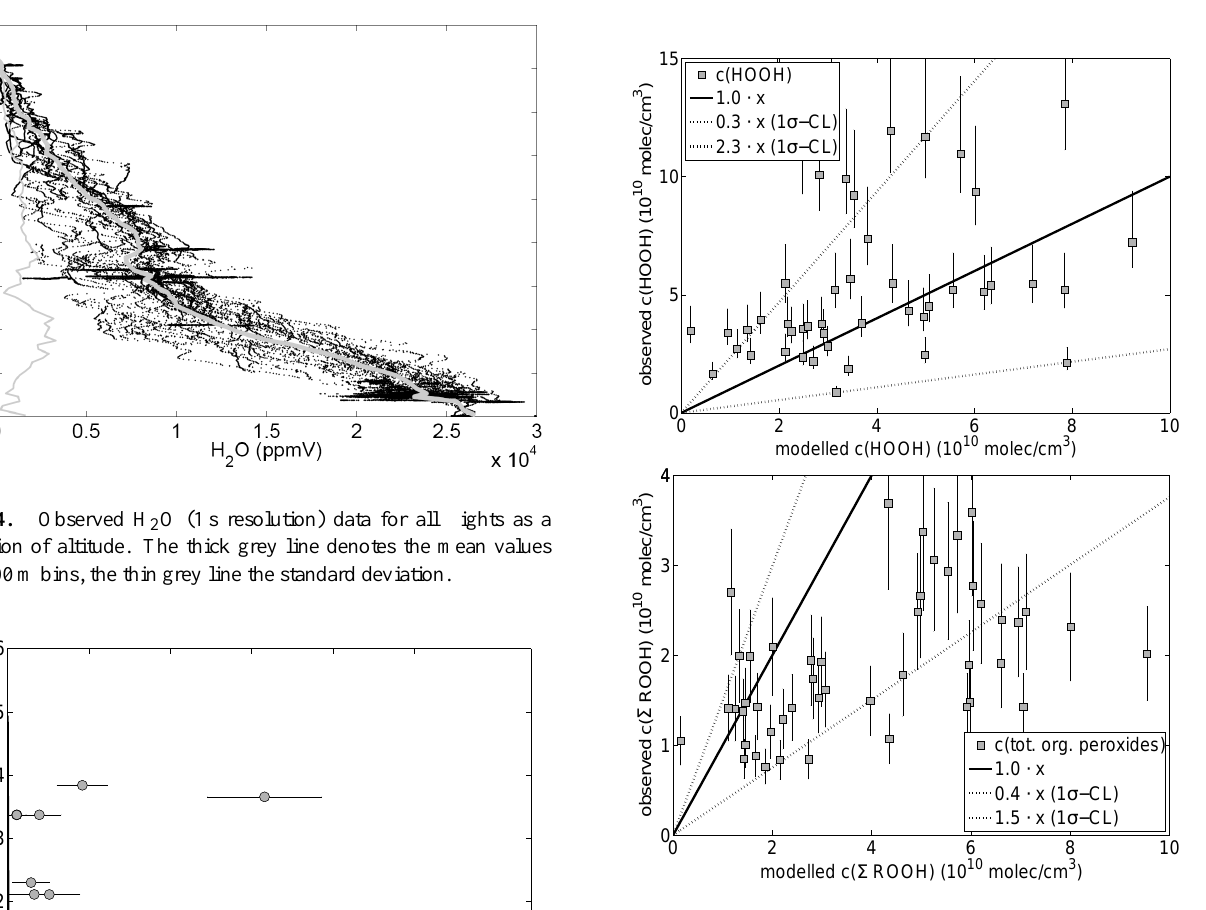
Fig. 6. Observed and modelled data for hydrogen peroxide (H 2 O 2 = HOOH) and total organic peroxides ( Σ ROOH). The solid line represent perfect agreement, the dashed lines bound the 1 σ confidence level (1 σ -CL).